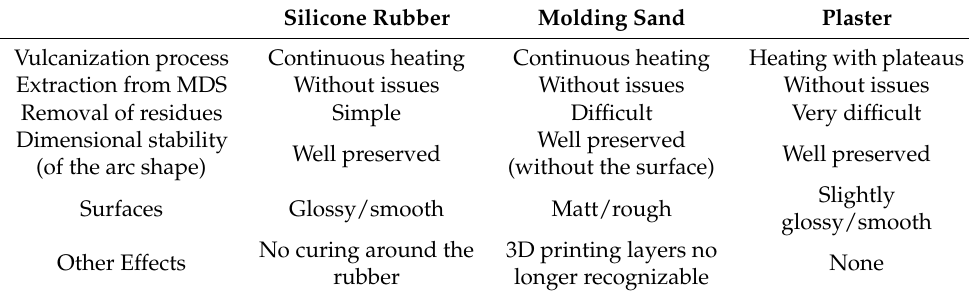
Table 2. Evaluation matrix for the suitability of the selected media as MDS. Silicone Rubber Molding Sand Plaster Vulcanization process Continuous heating Continuous heating Heating with plateaus Extraction from MDS Without issues Without issues Without issues Removal of residues Simple Difficult Very difficult Well Dimensional stability Well preserved (of the arc shape)